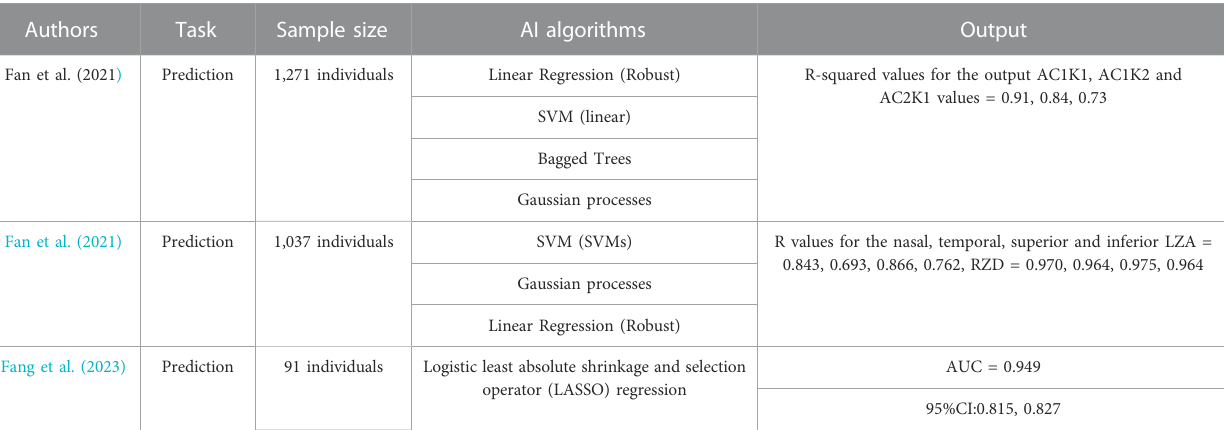
TABLE 1 ( Continued ) Application summary of different AI models and algorithms used in